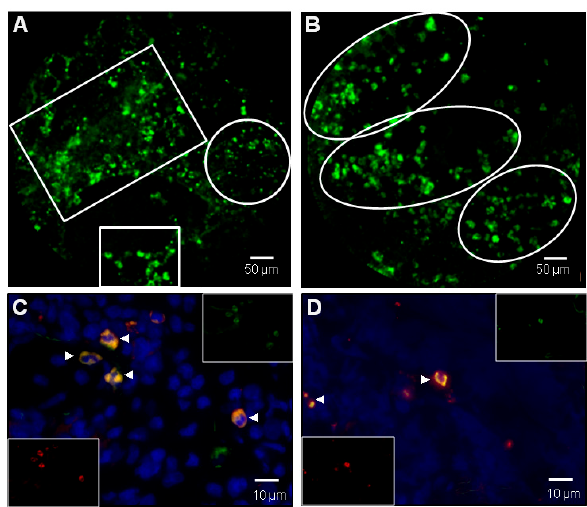
Figure 4. ( A ) Video capture of in vivo endomicroscopy imaging in a rat lung intratracheally instilled with a MPO specific activatable smart probe after 72 h hyperoxia [63]. In view, background fluid edema and airspace structures with numerous dots exhibiting high fluorescence intensity (HFI) concentrated in free inflammatory cells or cluster of cells ranging from 5 to 10 µ m (empty white squares) and displaying MPO cellular real-time activation [63]. Nebula of smaller HFI are presumably corresponding to extracellular bio-activation of MPO, especially in Neutrophil (polymorphonuclear neutrophils (PMNs)) extracellular traps (NET)-like structures (empty white circle) [60,61]. ( B ) Another panel of in vivo endomicroscopy imaging showing a low background grouping of distal airspace inflammatory free cells, mainly PMNs, with variable levels of MPO activation (empty white circles). Cellvizio ™ Dual Band (Mauna-Kea Tech.) imaging [63]. ( C ) Ex vivo MPO +/ elastase + cells in a rat lung after 72 h hyperoxia previously imaged in vivo in panels (A) and (B) . Coexpression of presumed PMNs is shown in orange (white arrows) and individual stainings are displayed in inserts [63]. ( D ) Similar conditions as in panel ( C) , showing MPO +/ CD68 + cells. Coexpression of presumed alvolar macrophages is shown in orange (white arrows) and individual stainings are displayed in inserts [63].